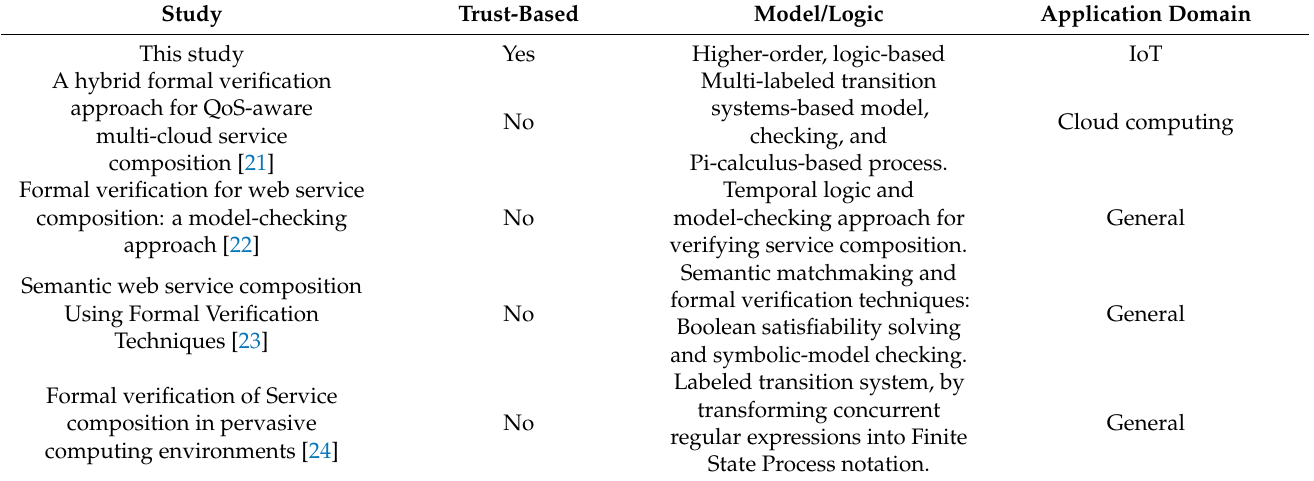
Table 1. Related